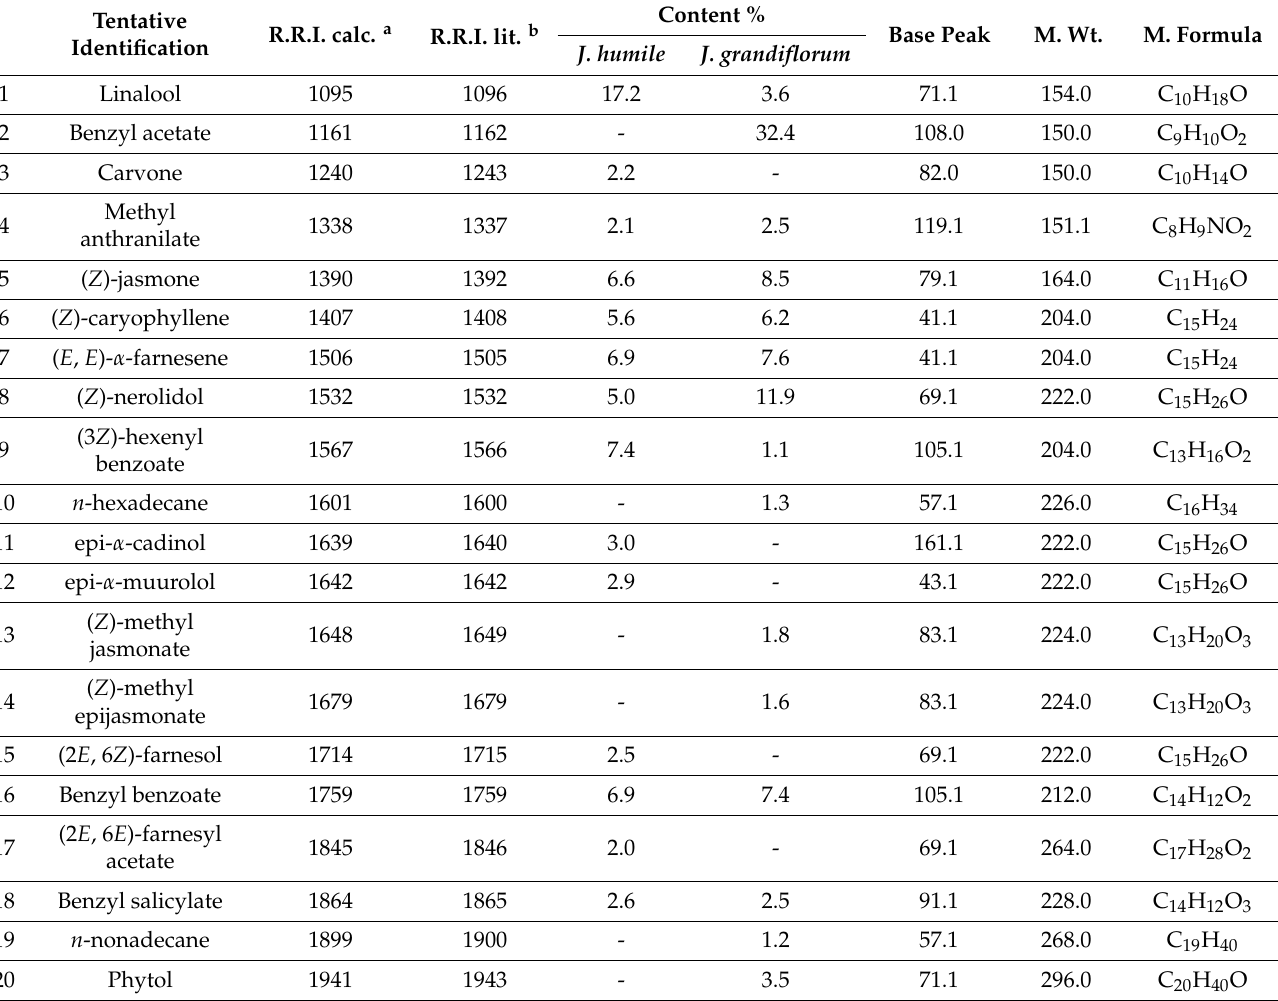
Table 1. GC-MS profiling of the essential oils obtained from freshly collected flowers of Jasminum humile L. and Jasminum grandiflorum